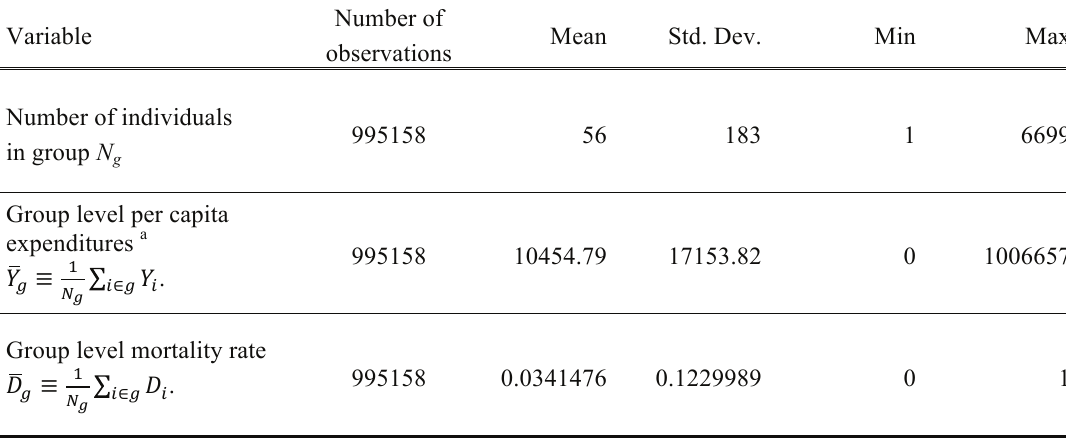
Table 2: Descriptive statistics of group level variables